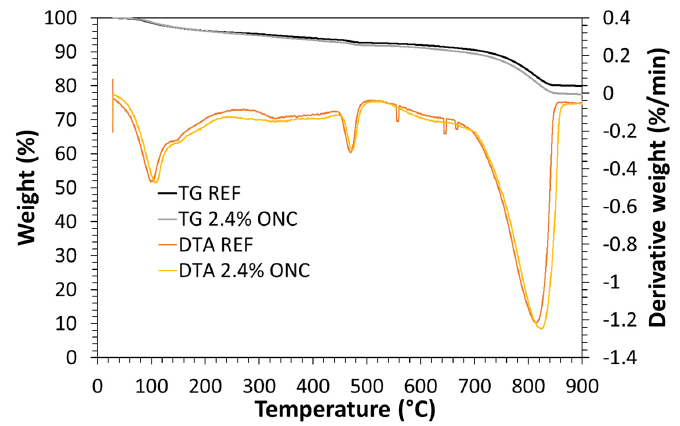
Figure 14. TGA measurements reporting samples percent weight and derivative weight for standard mortars without NC and a mortar with 2.4% ONC.